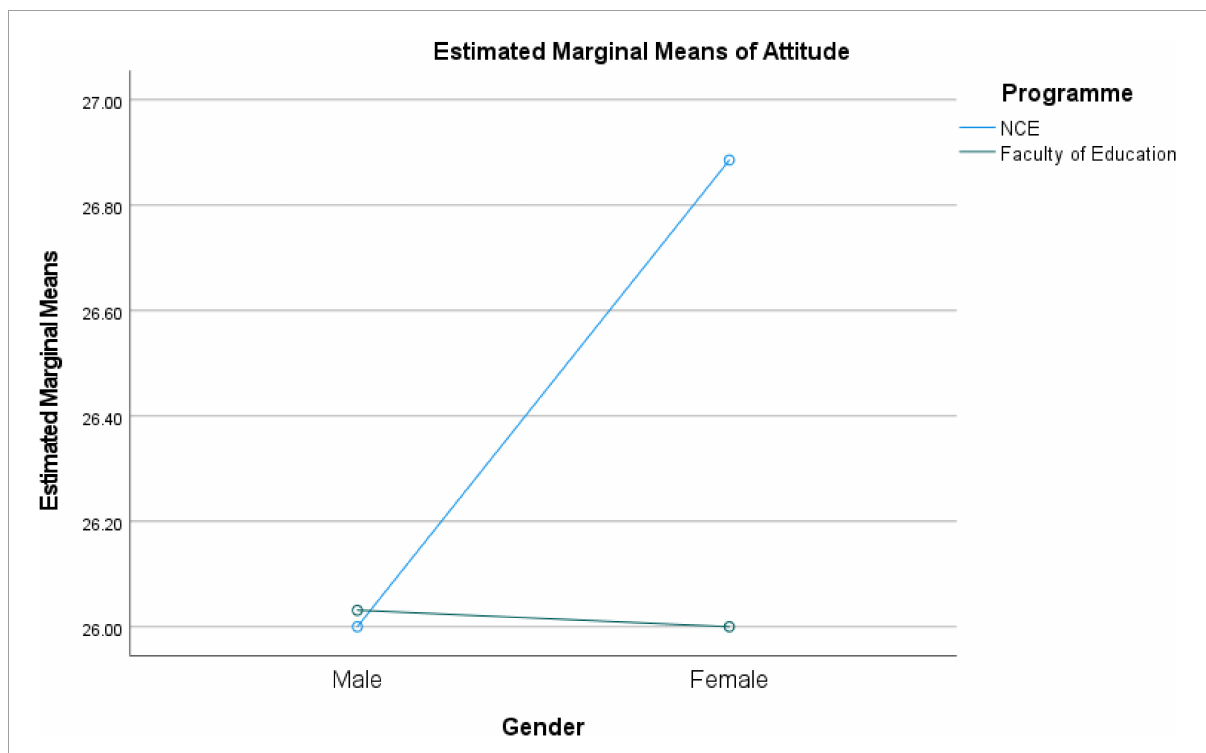
FIGURE3 Estimated marginal means interaction between gender and programs on pre-service teacher attitudes about inclusive